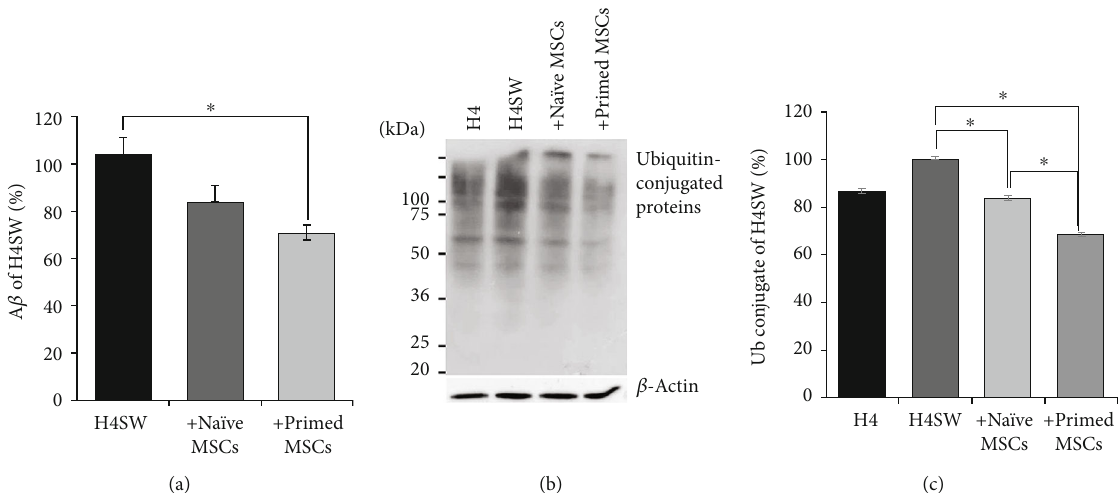
Figure 3: Therapeutic e ff ect on Alzheimer ’ s disease in vitro. (a) Secreted amyloid-beta levels in the conditioned media were measured by ELISA. ∗ p < 0 : 05 . (b) The degradation of ubiquitin (Ub) conjugates in H4SW cells with cocultured MSCs was measured by Western blots. The percentage of Ub conjugates was calculated as a percentage of that in the H4SW cells. (c) Changes in mRNA expression were evaluated. The data are presented as the mean ± S : E : M . Three samples per experimental group were tested in each assay. ∗ p < 0 : 05